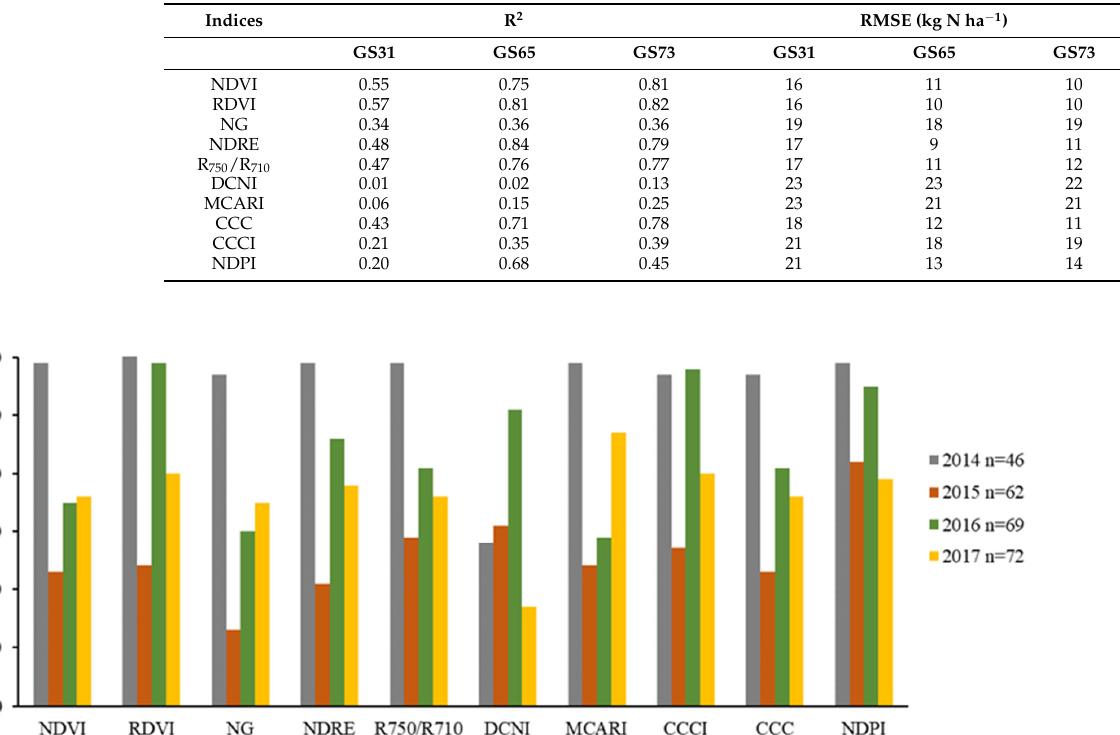
15 of 23 Table 4. Coefficient of determination (R 2 ) and root mean square error (RMSE) between vegetation indices and N output at the beginning of stem elongation (GS31), flowering (GS65), and early milk